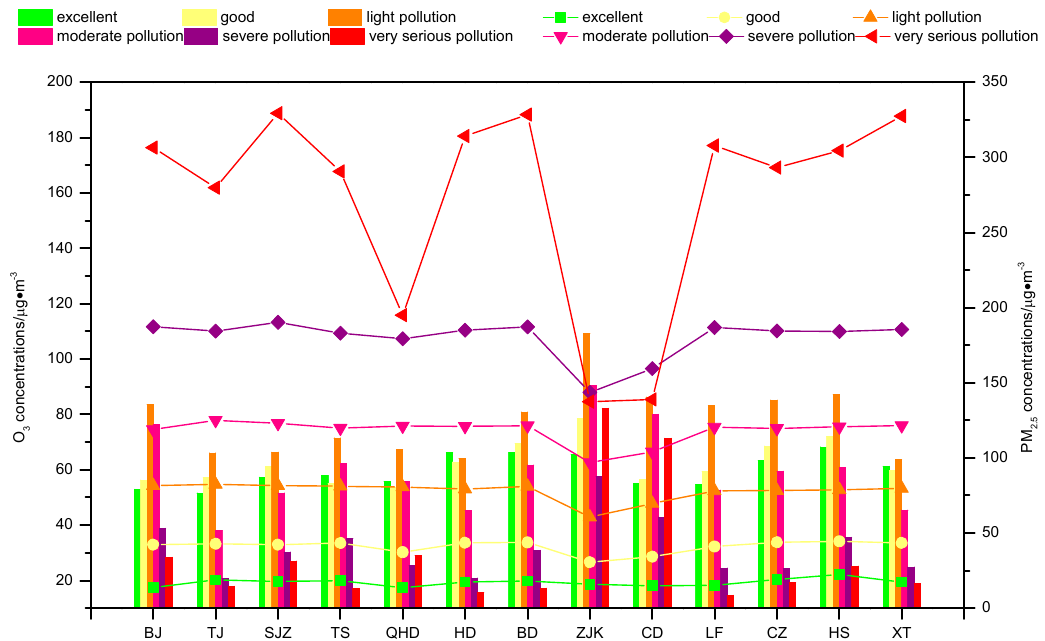
Figure 11. The O 3 (histogram) and PM 2.5 concentrations (line chart) at different air quality levels. Except ZJK and CD, the O 3 concentrations were mainly up to the highest at light polluted periods − 3 in BTH area, which ranged from 63.67 to 87.21 µ g · m . Secondly, the O 3 concentrations were